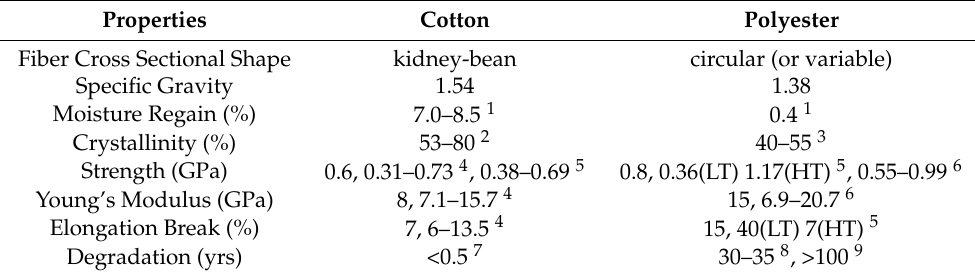
Table 1. Properties of cotton and polyester compiled from ref. [36] and other sources